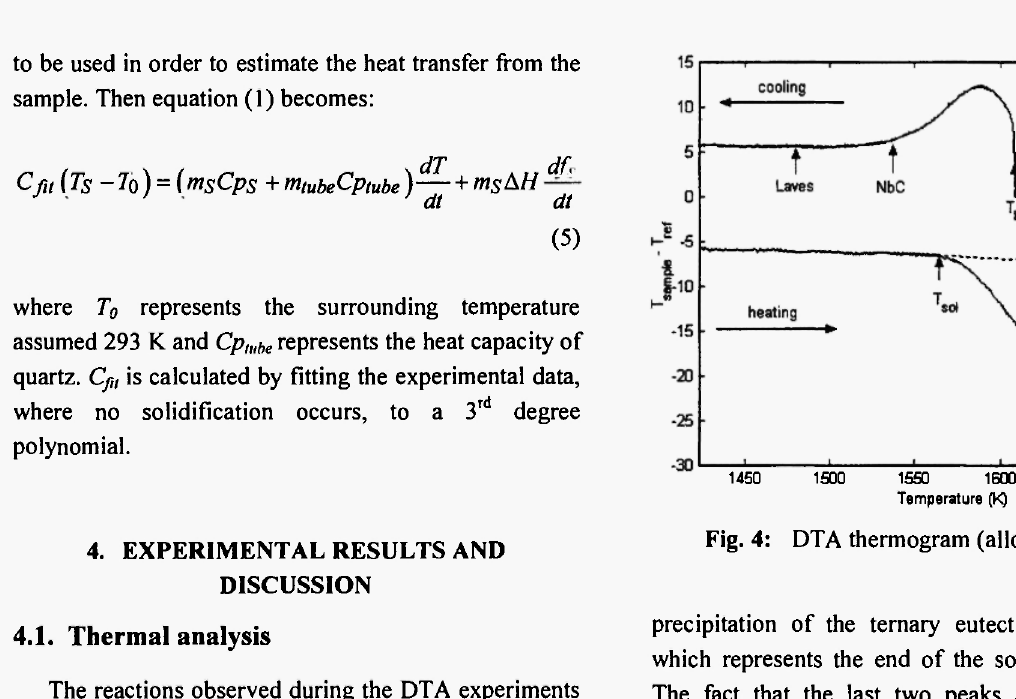
Fig. 4: DTA thermogram (alloy 3 - 702057)